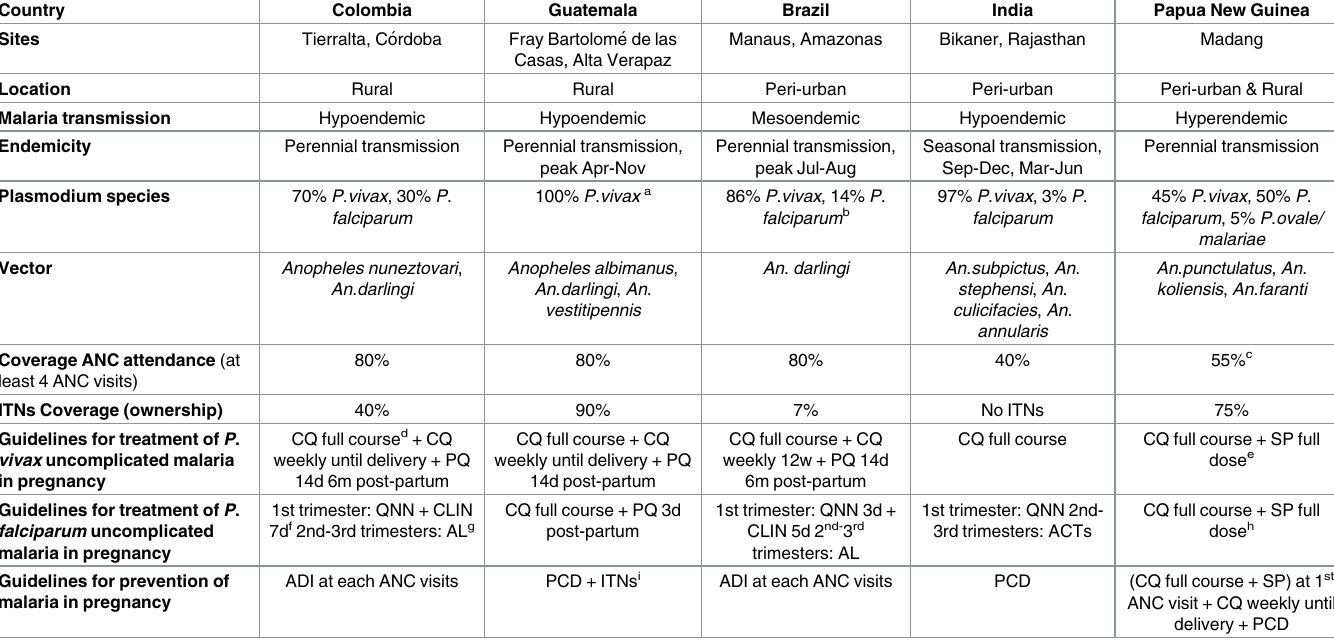
Table 1. Characteristics of the study